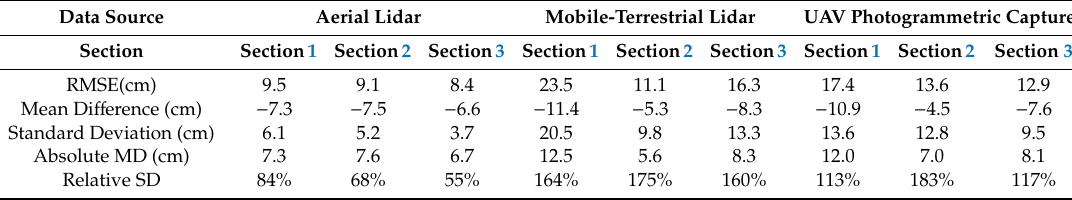
Table 3. Statistics Related to Di ff erence in Elevations for Three Sections.